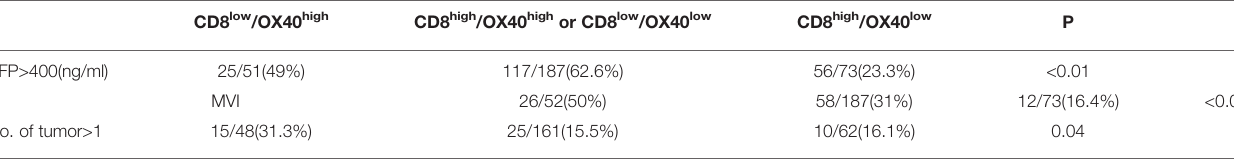
TABLE 3 | Association between the CD8+/OX40+ ratio and clinicopathological parameters. CD8 low /OX40